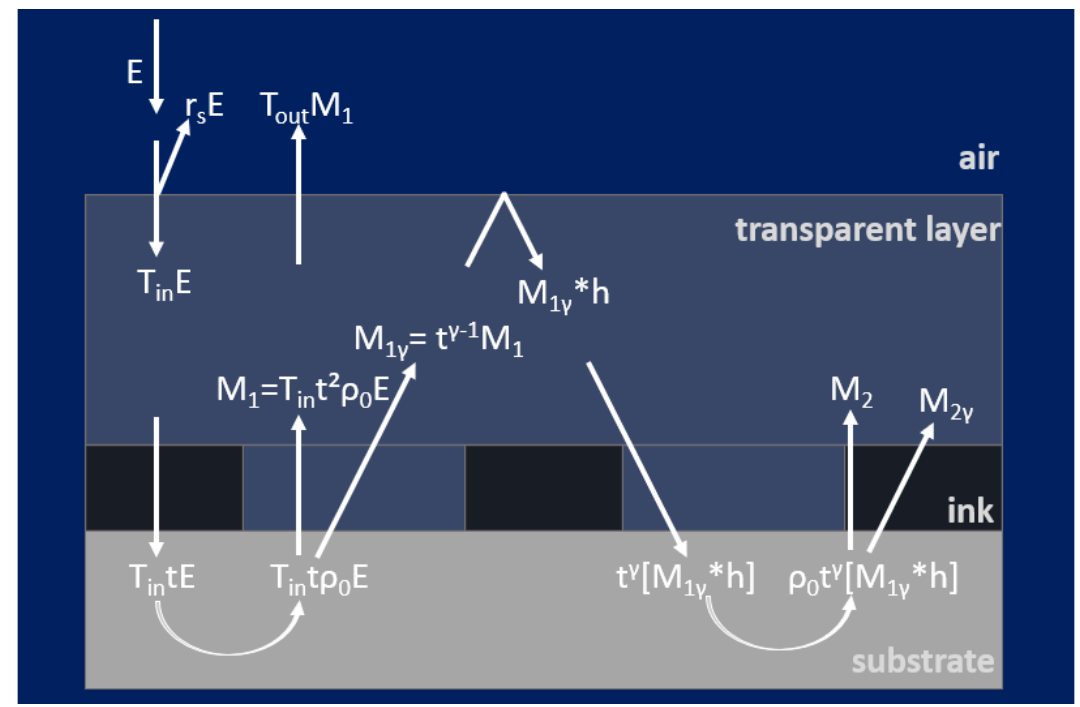
Figure 5. Scheme of the optical interactions within the coated halftone.